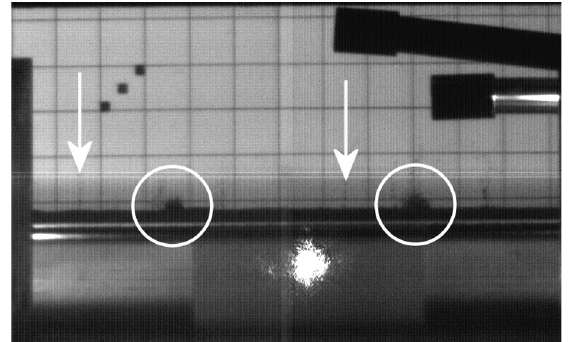
FIG. 10. Relationship between intensity and height of powder lift in all beam